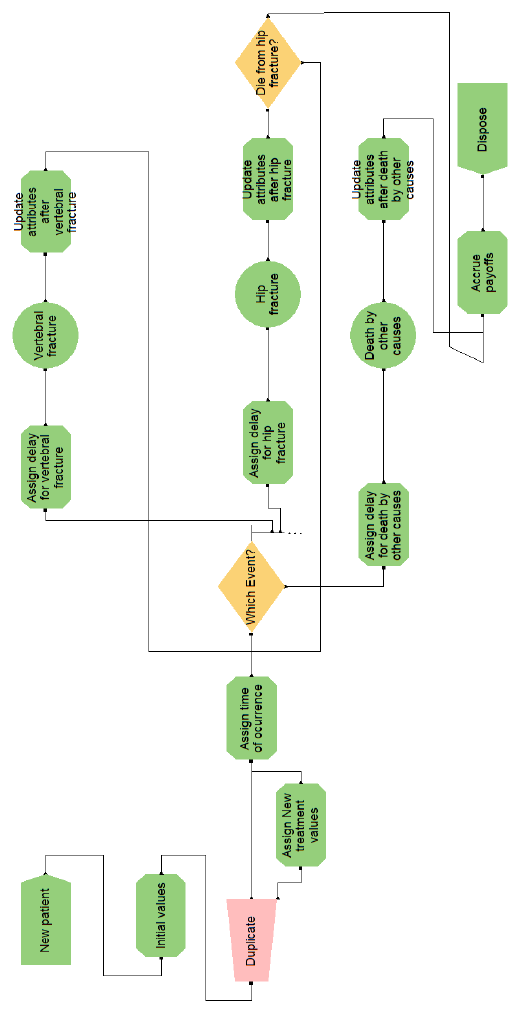
Figure A7. Flow diagram for the osteoporosis model in